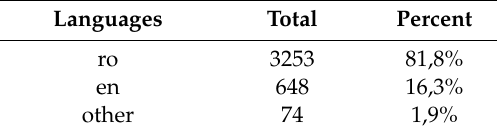
Table A45. Primary languages (ro).